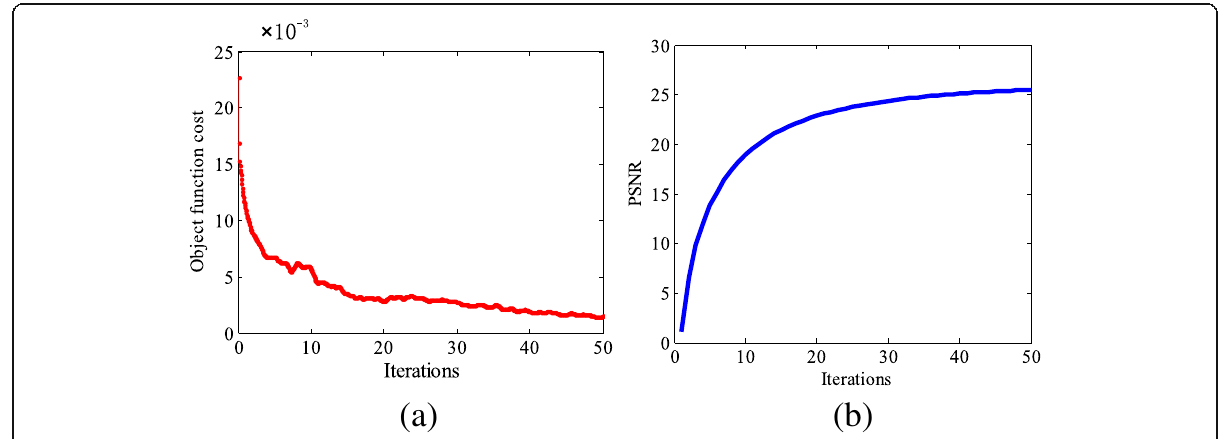
Fig. 3 Numerical analysis for iterations k . a Curve of object function cost to iterations. b Curve of PSNR to iterations